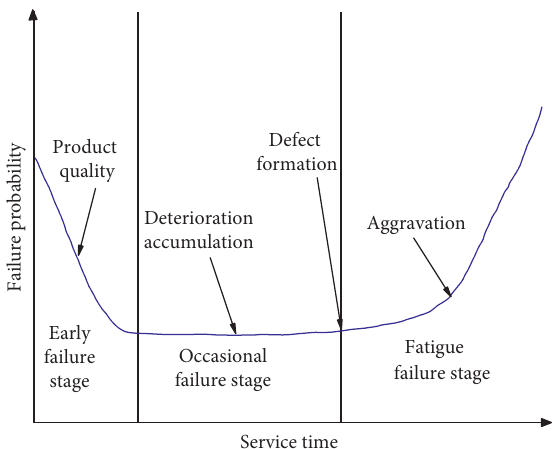
Figure 1: Bathtub curve of failure